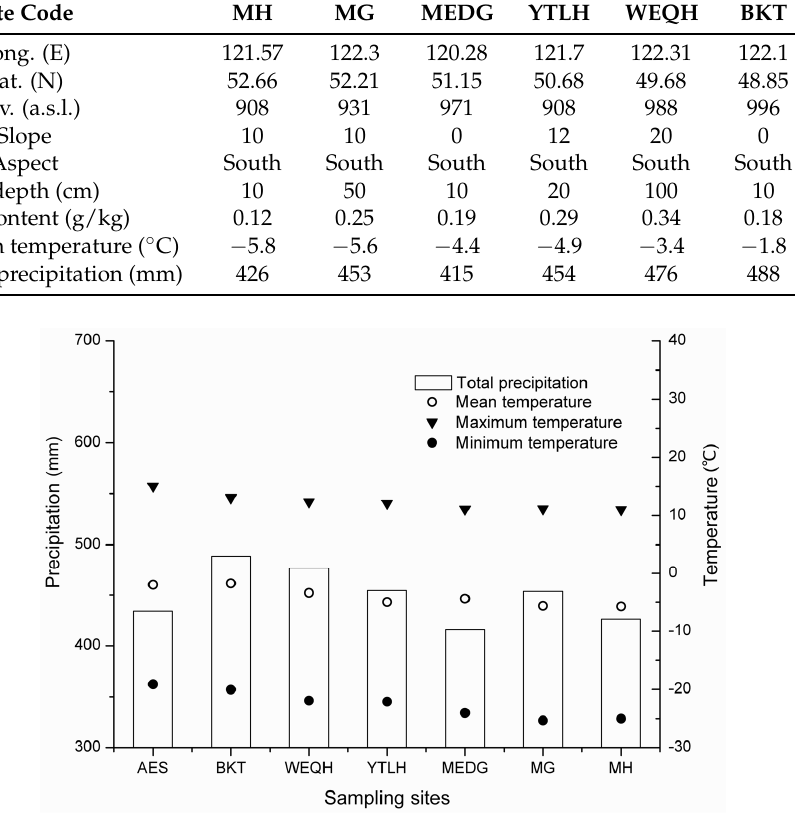
Figure 2. Annual maximum, mean, and minimum temperatures, and mean annual total precipitation from 1960 to 2013 along the latitudinal gradient from 47.27° to 52.66° N (from AES to MH) at the seven sites in the Greater Khingan Mountains of the western Chinese boreal forest.